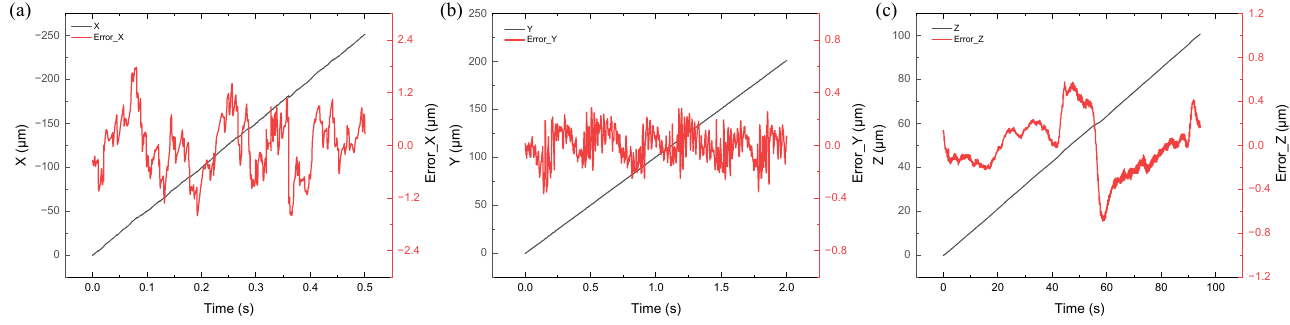
Figure 5. Displacement measurement results and errors of three-DOF: ( a ) X direction; ( b ) Y direction; ( c ) Z direction.